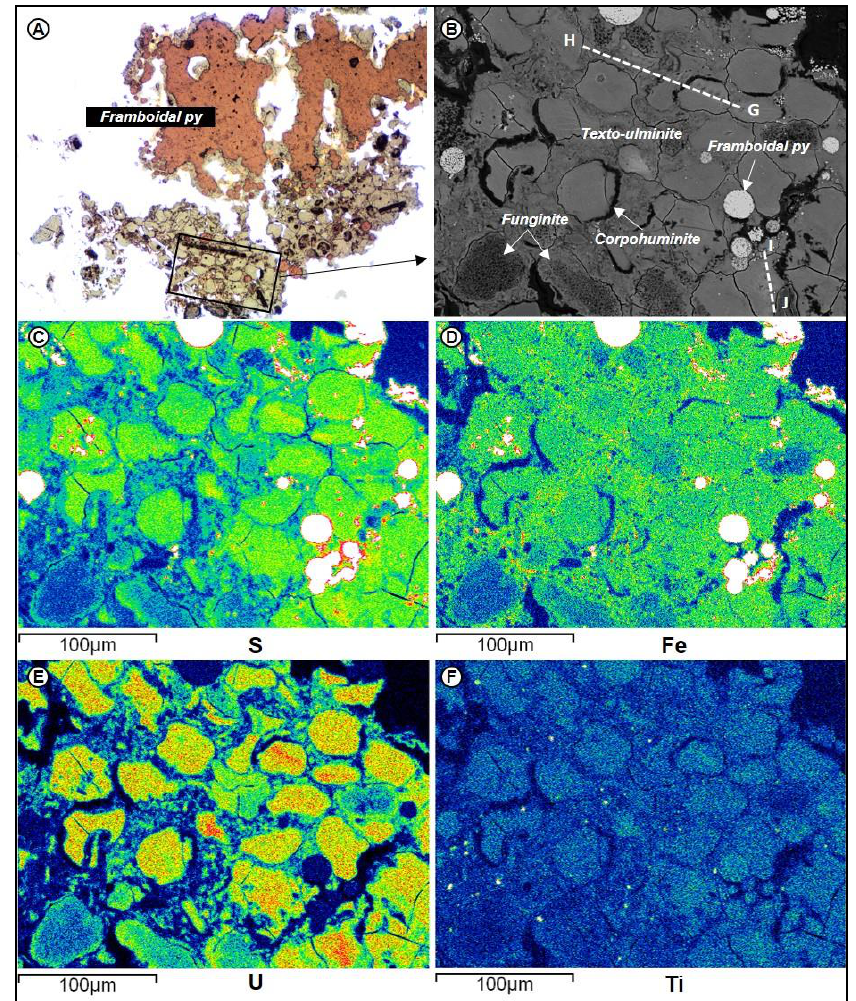
Figure 5. Organic matter relationships to U, Fe, S and Ti. The macerals corpohuminite, texto-ulminite and funginite are locally associated to framboidal pyrite ( A ) under reflected light and ( B ) in SEM mode. ( C – F) The SEM-EDS maps for S, Fe, U and Ti suggest that sulfur and iron are present in all particles, showing a preference for corpohuminite, then for texto-ulminite and finally for funginite.